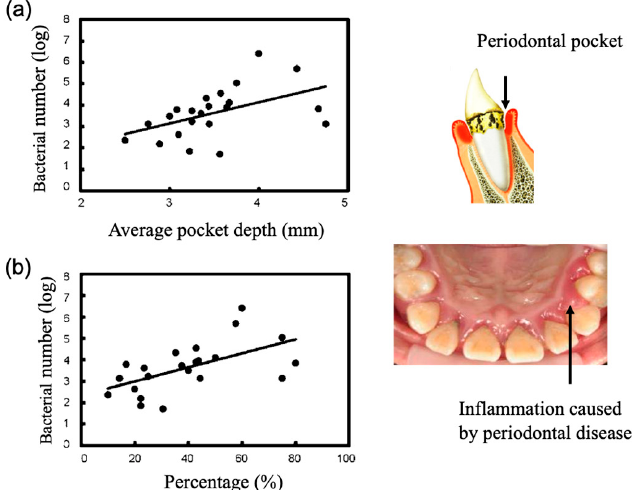
Figure 10. Relationship between periodontal pocket depth and PG bacterial number estimated by our electrochemical method [15]. ( a ) Plot between the number of PG bacteria and the average pocket depth; ( b ) Plot between the number of PG bacteria and the percentage of the periodontal teeth in which the periodontal pocket depth was greater than 4